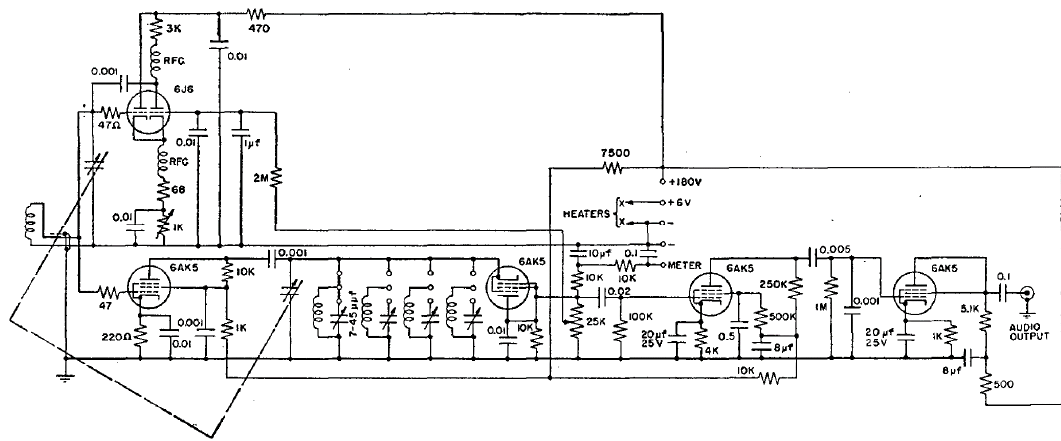
Figure 7. The classic valve based marginal oscillator. (reproduced with permission from [21]. Copyright AIP, 1950).